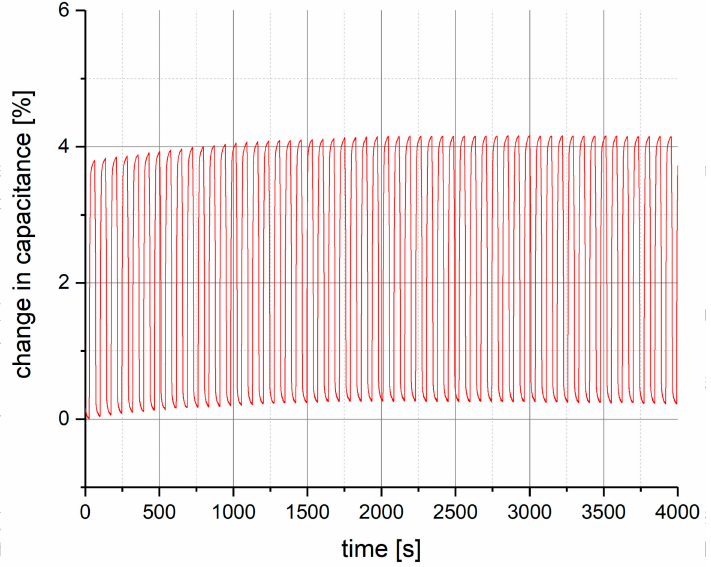
Figure 5. The change in capacitance as a function of time for the first hour of a long-time measurement